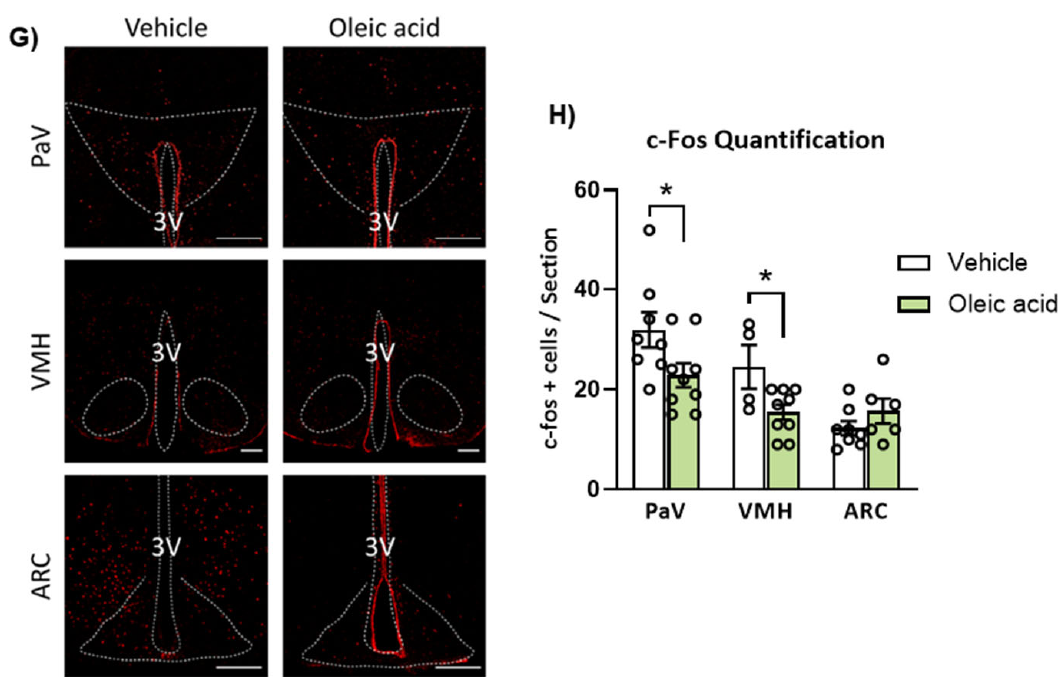
Figure 7. Effects of intracerebroventricular (ICV) administration of oleic acid on the expression of ACC, AMPK and FAS and neuronal activation in the hypothalamus of CPT1C-KO mice. ( A – C ) Representative blots of pACC, ACC, pAMPK, AMPK and FAS and ( D – F ) quantification of the pACC/ACC and pAMPK/AMPK ratios and FAS protein levels in the hypothalamus of mice after 48 h of ICV administration of oleic acid. ( G ) Representative images and ( H ) quantification of immunohistochemistry for c-Fos expression (c-Fos positive cells) in paraventricular (PaV), ventromedial (VMH) and arcuate (ARC) nucleus of the hypothalamus after 48 h of ICV administration of oleic acid. Data are represented as mean ± SEM (panels D – F : 2 blots from 8 different mice per group; panel H: n = 3 per group, 2–3 slices/mice). * p < 0.05, ** p < 0.01 vs. its corresponding vehicle. FAS: Fatty acid synthase. OA: oleic acid; V: vehicle. 3V: third ventricle. Scale bar = 250 μ m.